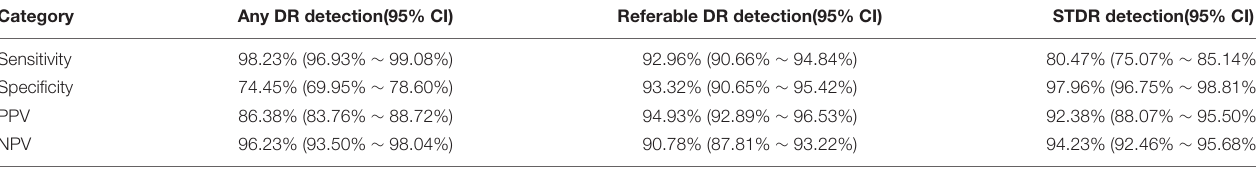
TABLE 2 | Performance of EyeWisdom V1 in comparison to manual grading.